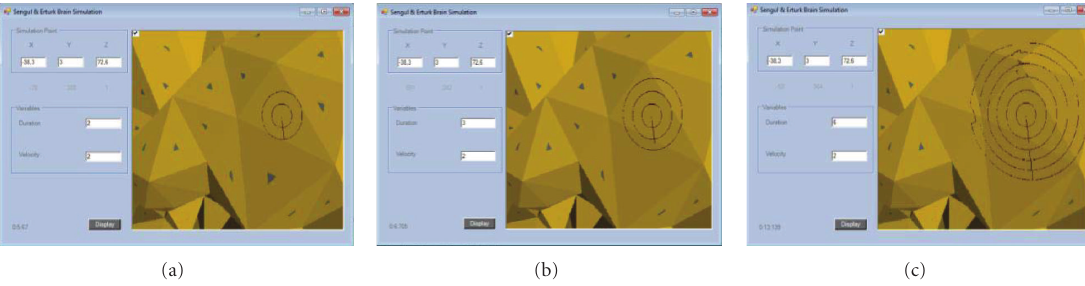
Figure 4: Electrically active and inactive dipoles after the initiation of SCD. The brown lines show the SCD boundaries, and gray triangles show the electrically active dipoles. The electrical dipoles inside the SCD are suppressed and disabled in the figures. The figure on the left shows the SCD boundaries and electrically active dipoles after the 10 seconds of the initiation of SCD, the middle one shows the SCD boundaries and electrically active dipoles after the 20 seconds of the initiation of SCD, and the last one (on the right) shows the SCD boundaries and electrically active dipoles after 60 seconds of the initiation of